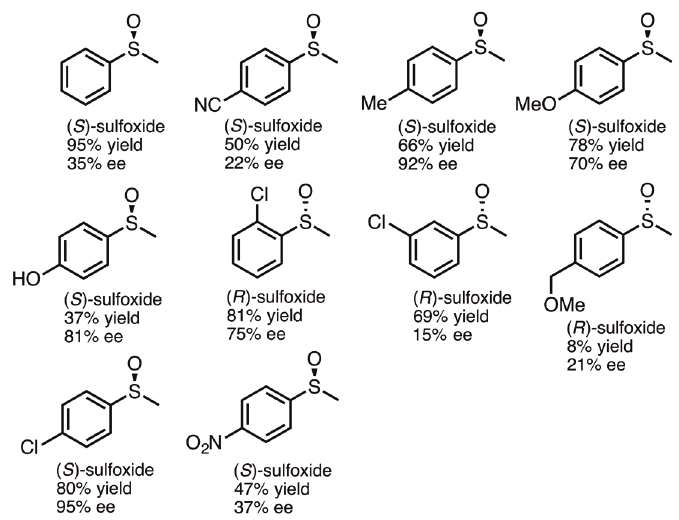
Figure 15 - Sulfoxides prepared from reactions with flavin-containing monooxygenase (FMO), fused to phosphite dehydrogenase (Rioz- Martinez et al.